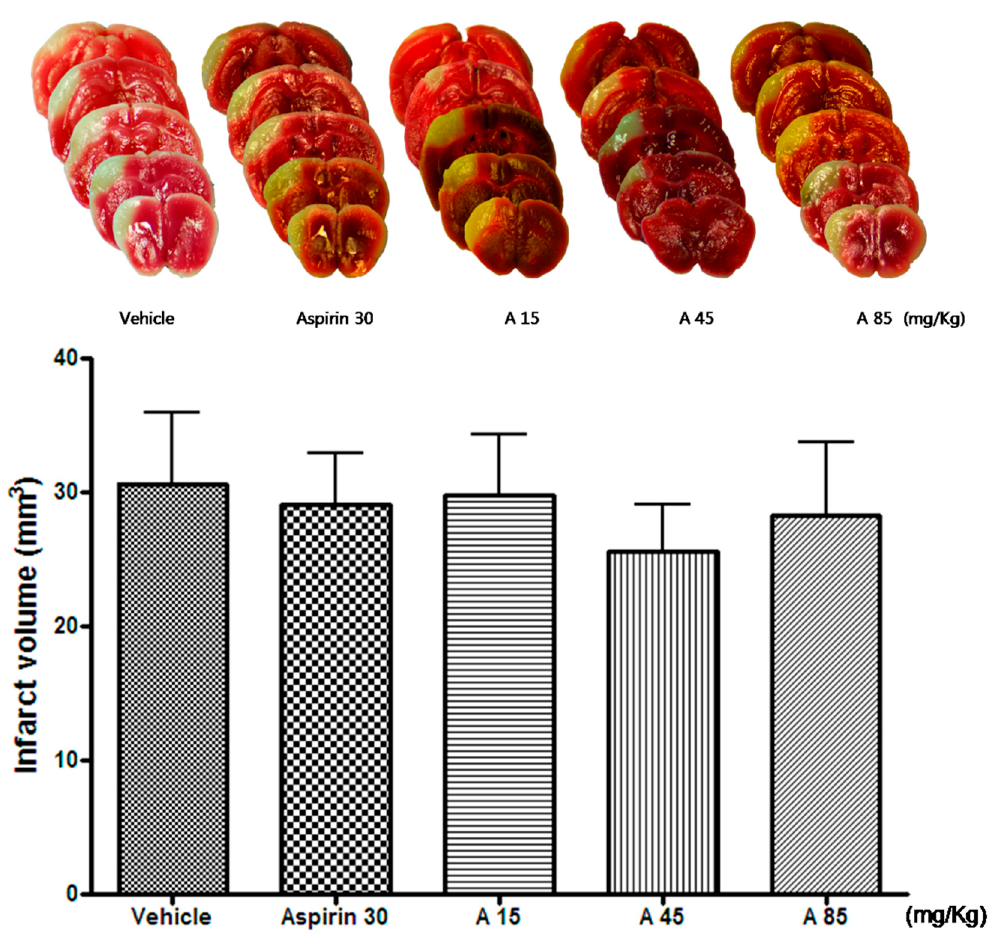
Figure 8. Effects of Sample A on ischemic brain injury after permanent middle cerebral artery occlusion (pMCAO). Infarct volume was measured 24 h after pMCAO. ( Upper ) Representative photographs of infarcted brain slices from vehicle- and Sample A-treated mice. ( Lower ) There was no significant among-group difference in the cortical infarct volume after 24 h ( n = 8–10 mice for each group). Data represent means ± standard deviation. A, Chunghyuldan.